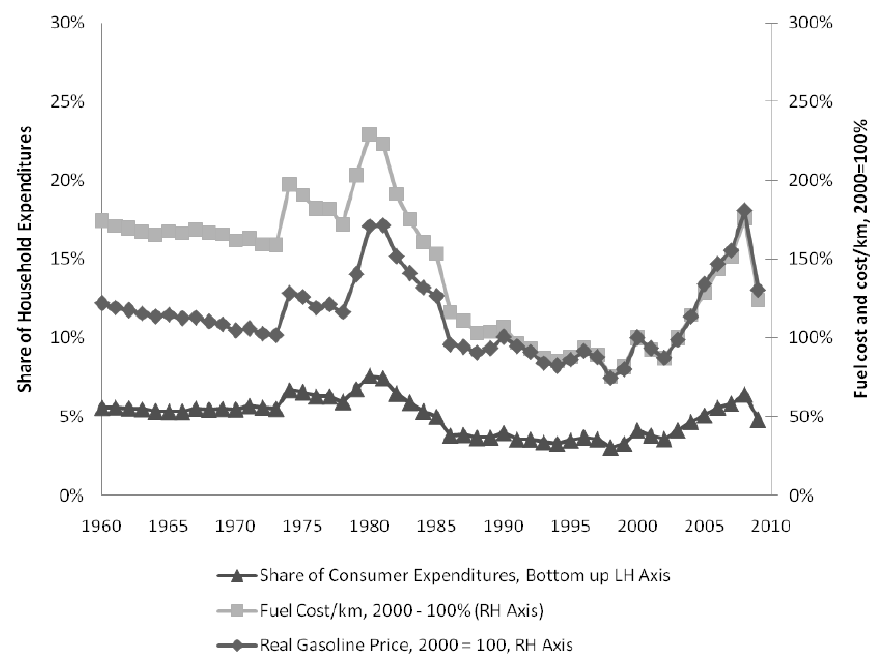
Figure 8. Changes in real and relative road fuel prices,